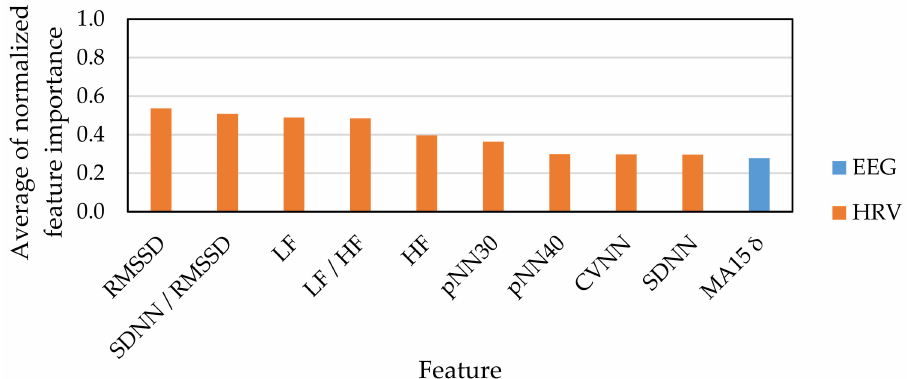
Figure 8. Feature selection result for low arousal and high arousal.